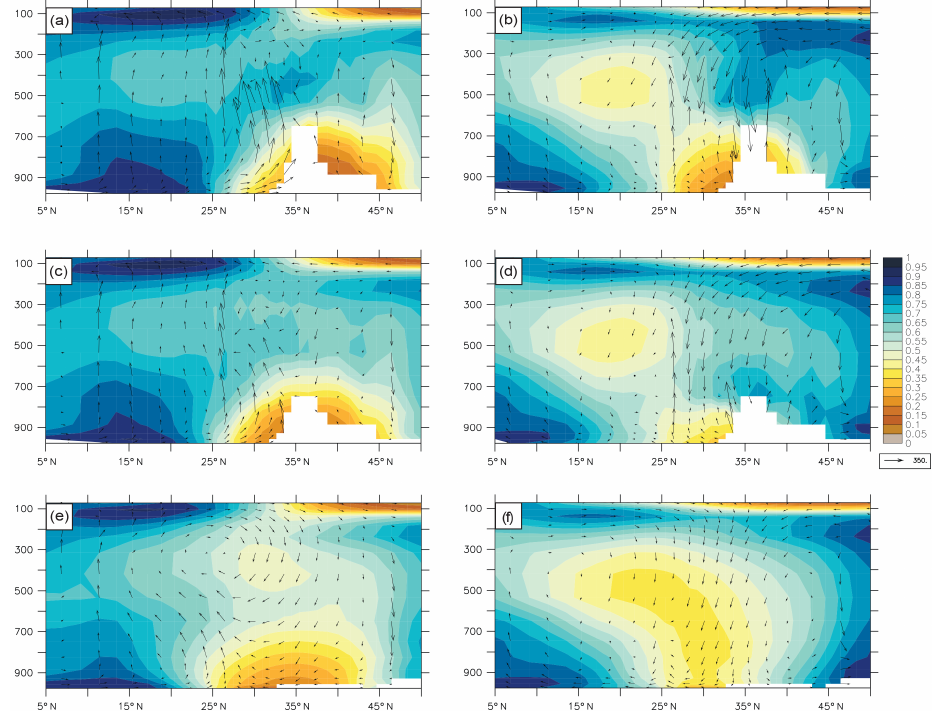
Figure 4. Cross-TP profiles (averaged between 70 and 90 ◦ E) showing the relative humidity and moisture transport for seasons (a, c, e) MJJAS and (b, d, f) ONDJFMA and for three simulations: (a, b) MOD, (c, d) INT, (e, f) LOW cases.